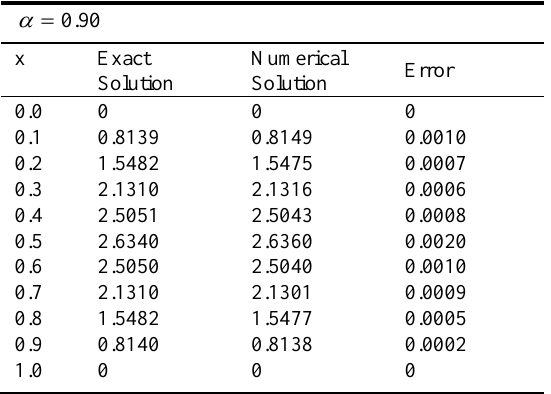
Table 2. Numerical results for